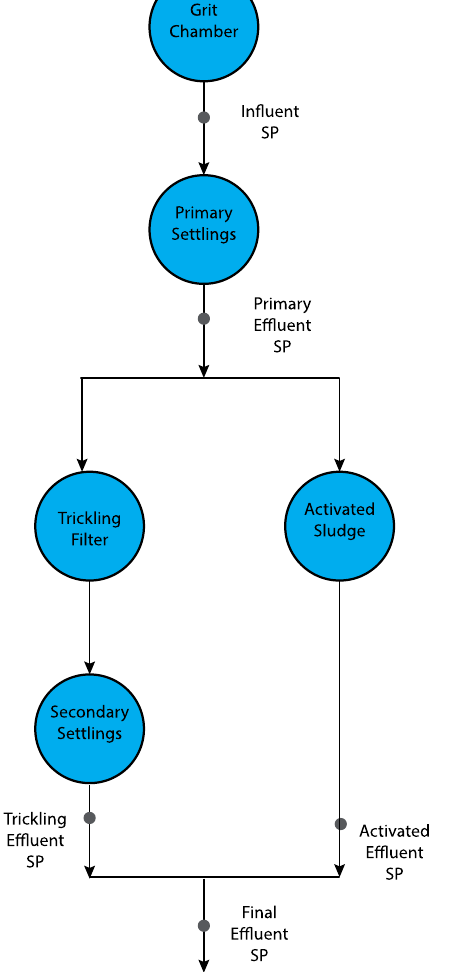
Fig. 1 The treatment processes I influent, PE primary effluent, T trickling filter effluent, A activated sludge effluent, and FE final effluent and SP sampling